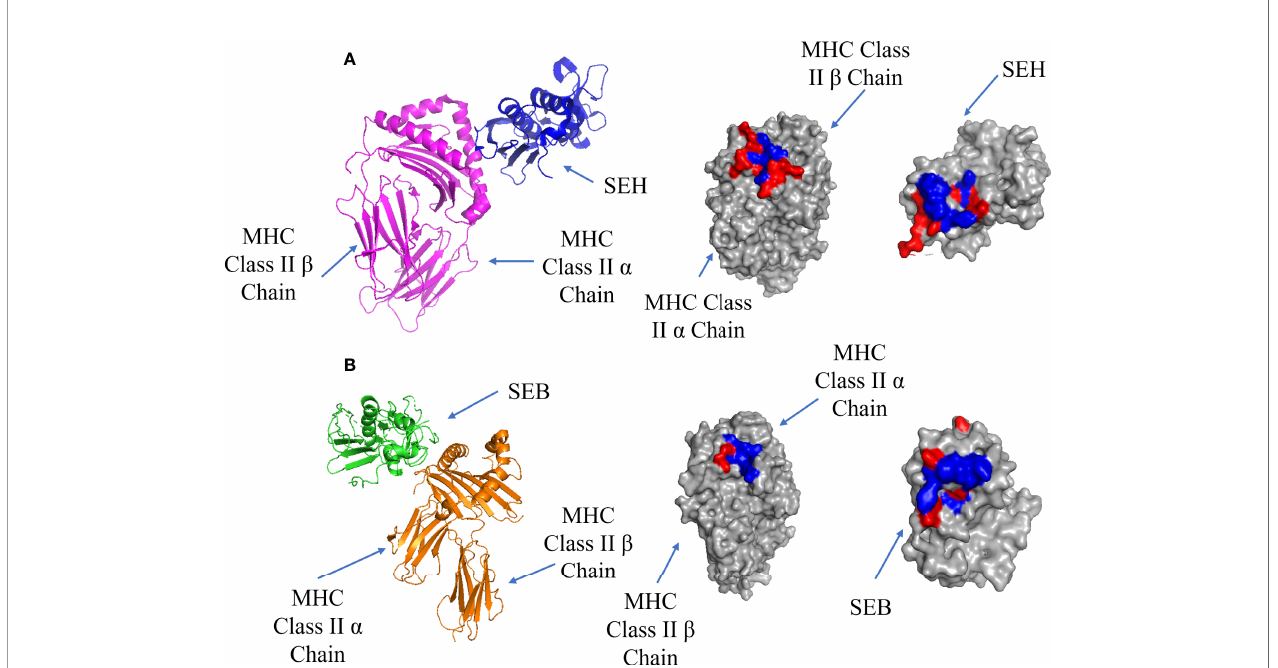
FIGURE 3 | Binding of SEH and SEB superantigens to -MHC Class II. (A) Left panel: ribbon plot of SEH (blue) bound to the high af fi nity site on MHC Class II a Chain (purple) (PDB code: 2XN9). Middle Panel: MHC Class II showing polar (red) and hydrophobic residues (blue). Right Panel: SEH. (B) . Left panel: ribbon plot of SEB (green) bound to the low af fi nity site on MHC Class II b Chain (orange) (PDB code: 1SEB). Middle panel: MHC Class II b Chain. Right panel: